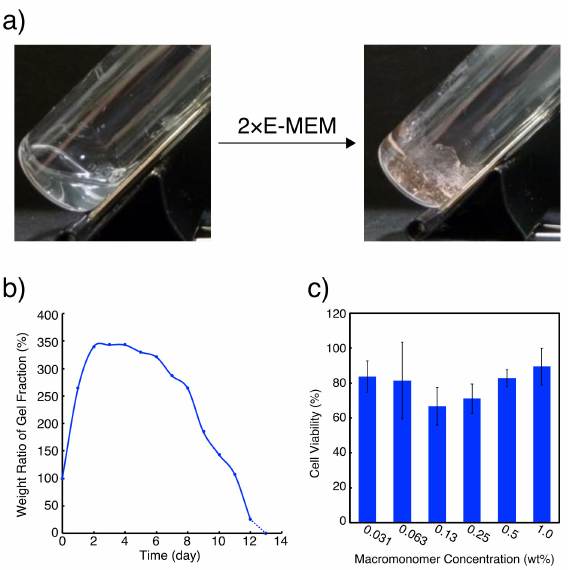
Figure 2. ( a ) Photographs of 20 wt % L4.6k-dG4 before ( left ) and after ( right ) the addition of equal volume of 2 × E-MEM. ( b ) Swelling and erosion profile of DNA quadruplex hydrogels in 1 × E-MEM at 37 ◦ C. ( c ) WST-8 cell viability assay of L929 mouse fibroblast cells treated with L4.6k-dG4 solution. Cells were cultured in 96-well plates in the presence of L4.6k-dG4 at various concentrations for 24 h. Cells without L4.6k-dG4 treatment were used as negative control. Cell viability was 84 ± 9, 82 ± 22, 67 ± 11, 71 ± 8, 83 ± 5, and 90 ± 11% in 0.031, 0.063, 0.13, 0.25, 0.50, and 1.0 wt % L4.6k-dG4 solution, respectively.